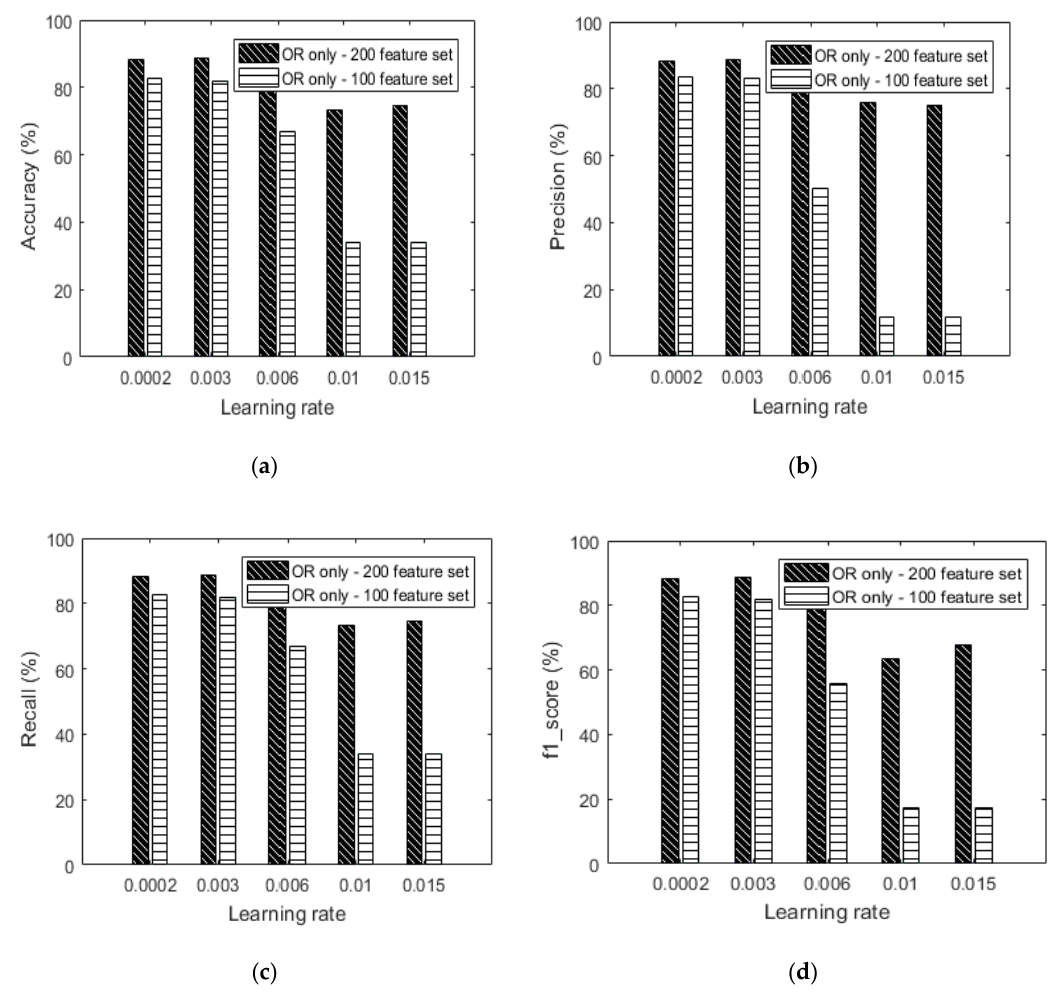
Figure 14. ( a ) Accuracy versus learning rate based on only the OR dataset without augmentation, ( b ) precision versus learning rate based on only the OR dataset without augmentation, ( c ) recall versus learning rate based on only the OR dataset without augmentation and ( d ) f1_score versus learning rate based on only the OR dataset without augmentation.